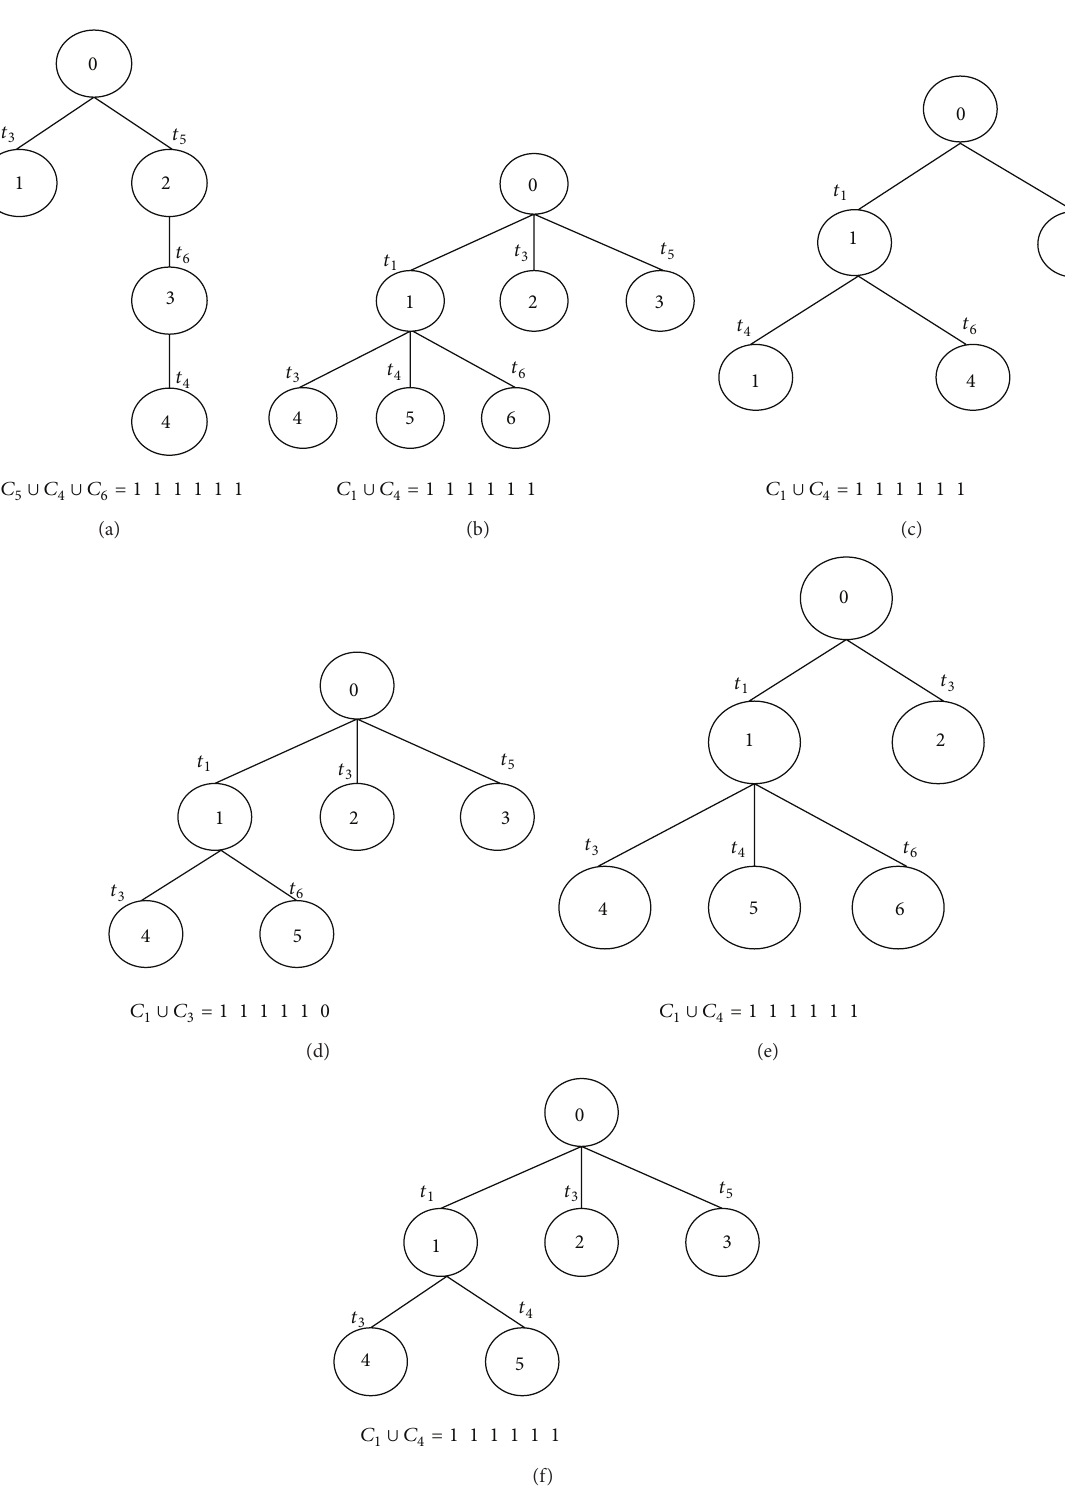
Figure 8: Different stages of getting optimum solution. 𝑇 𝑥 removed (a) 𝑅 1 , (b) 𝑅 2 , (c) 𝑅 3 , (d) 𝑅 4 , (e) 𝑅 5 , and (f) 𝑅 6